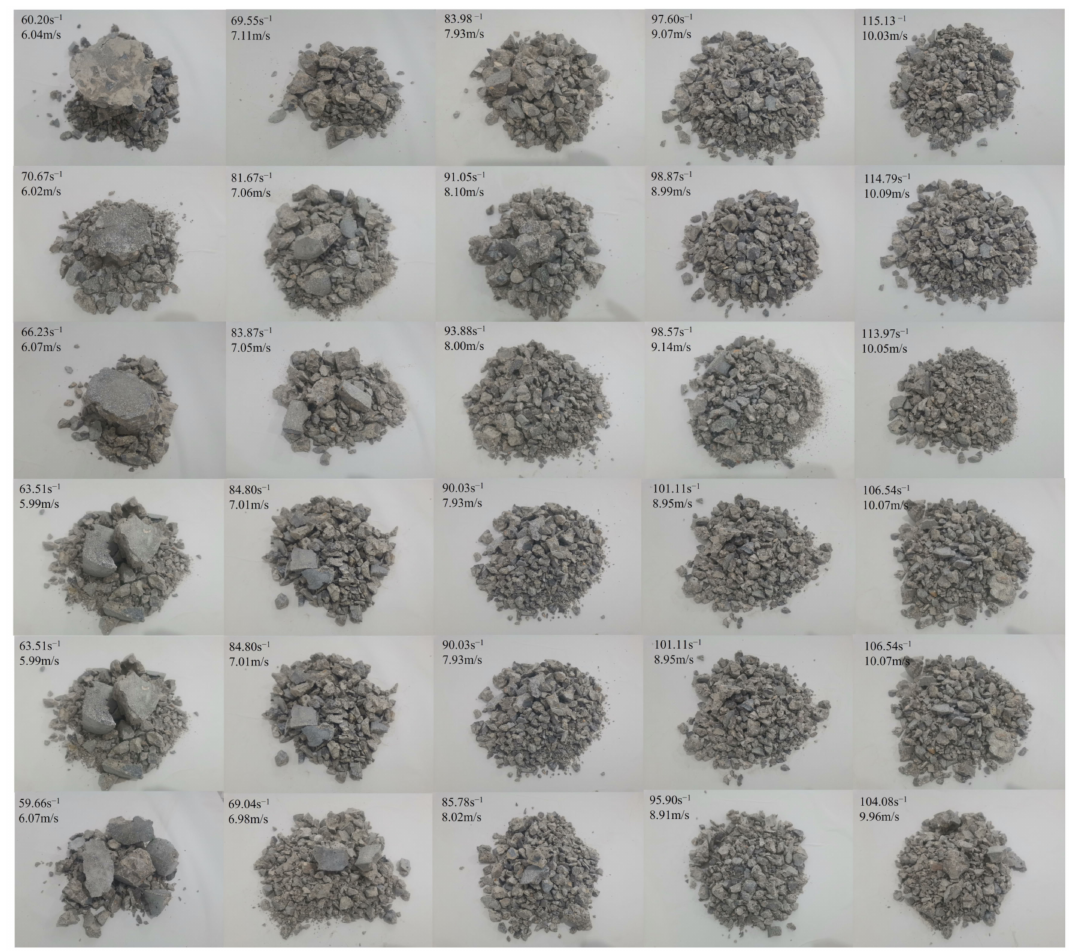
Figure 5. Breakage of specimen after impact